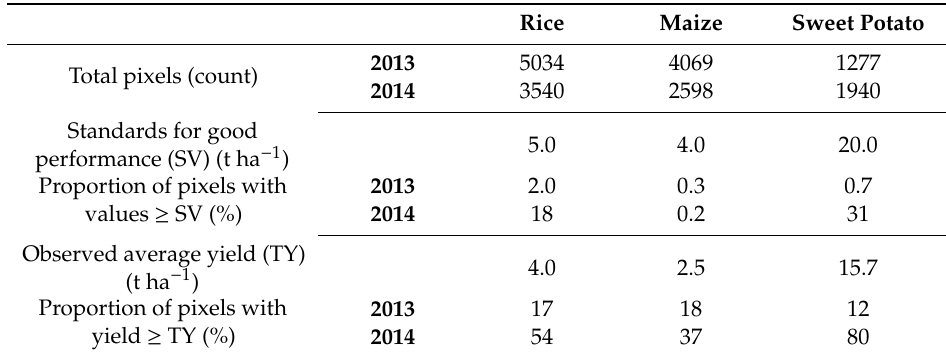
Table 4. Ranges of estimated yield and proportions of crop areas with good performance in terms of yield for rice, maize, and sweet potato in the Kou Valley irrigation scheme during the dry season production periods in 2013 and 2014.